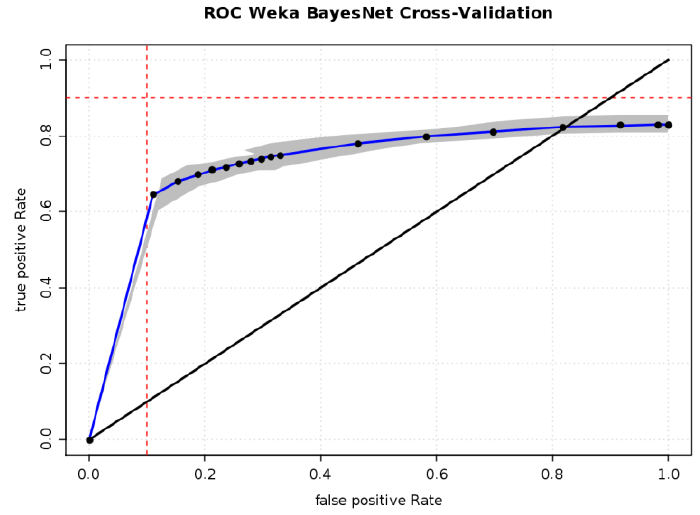
Figure 12. ROC-Curve for Bayes Net classifier.